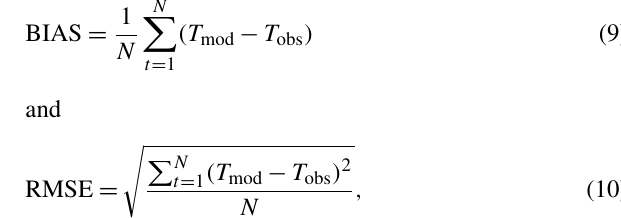
Vegetation root depth